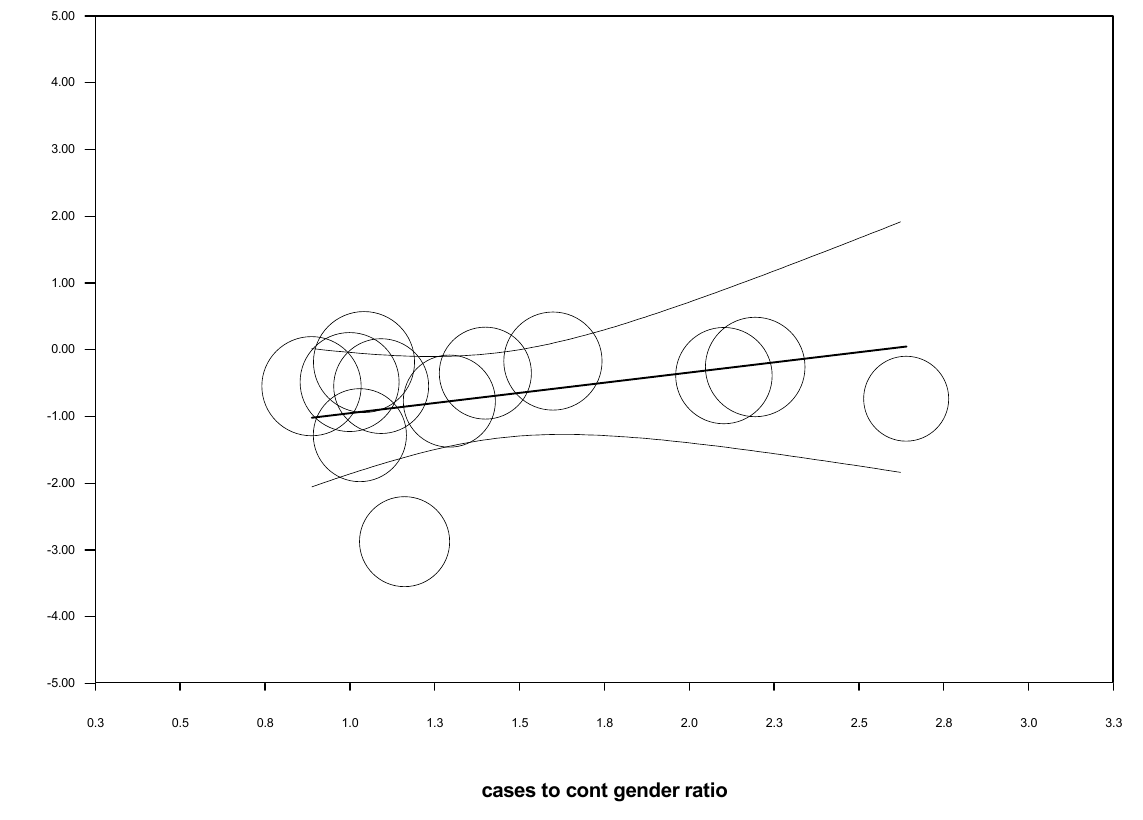
Figure 8. Cases vs. Controls: Scatterplot for Gender Ratio in Cases to Controls. Table 3. Random effect meta-regression analysis of 25-hydroxy-vitamin D